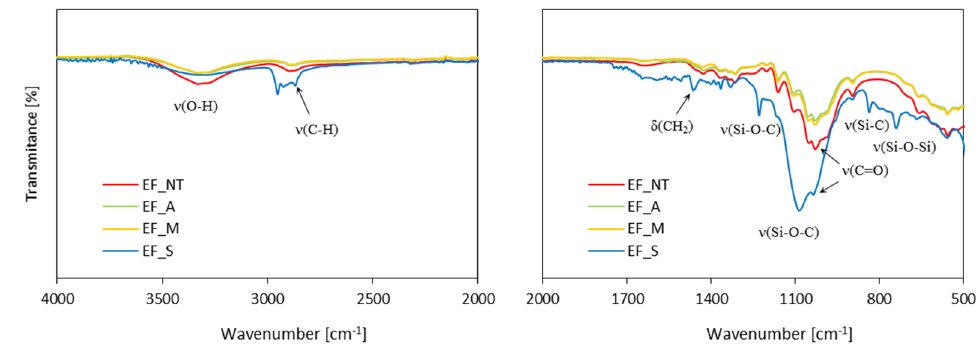
Figure 6. Fourier-transform Infrared Spectroscopy (FTIR) spectra of chemically-treated eucalyptus fibers.